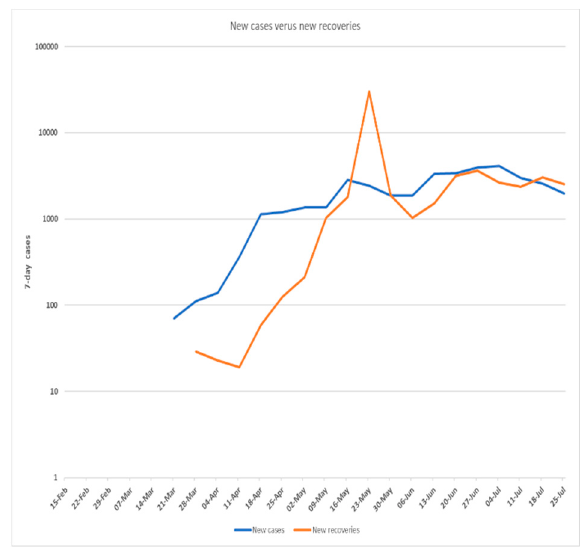
Figure 2. COVID-19 newly infected cases versus newly recovered cases in Saudi Arabia recorded from 15 February–21July 2020 ( Using logarithmic scale based 10 ).